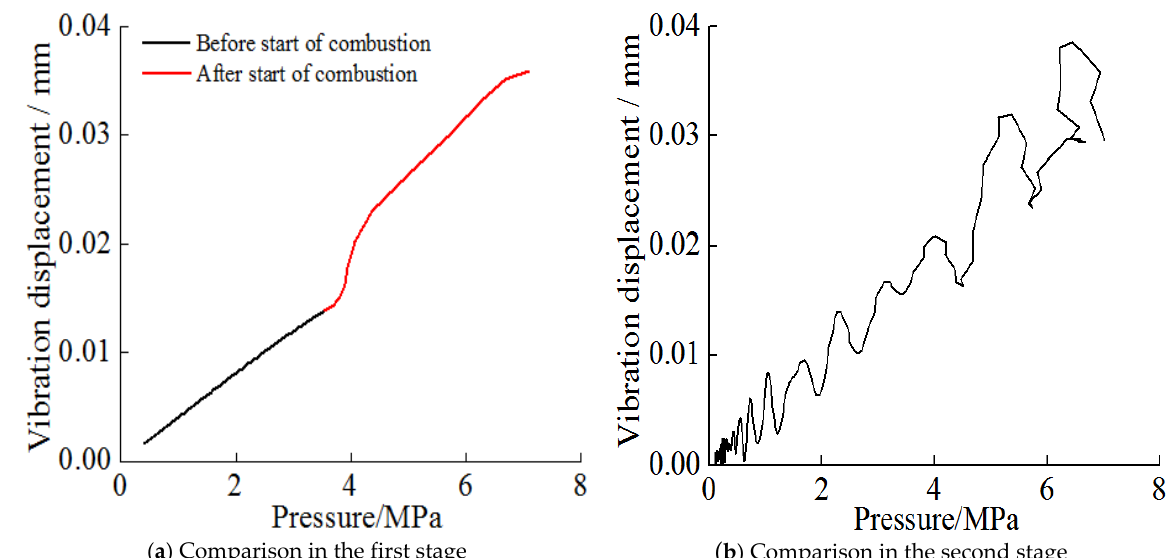
Figure 9. The two-stage relationship between combustion pressure and vibration displacement.